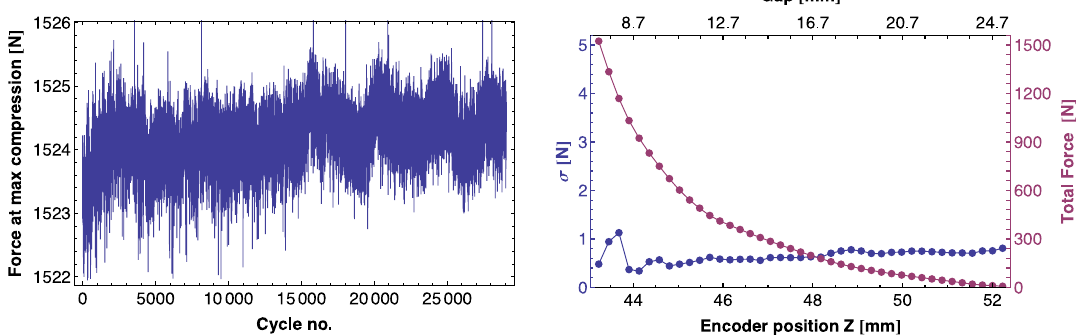
FIG. 17. Spring unit force at maximum compression (left), recorded over 30000 cycles. The force from the spring unit and the σ deviation are shown at right vs